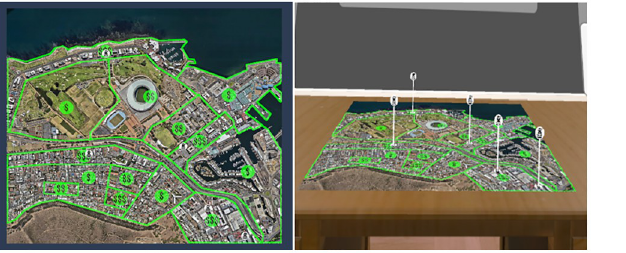
Fig 2. A map as displayed on a desktop monitor, with income level and robberies selected, compared to the same information displayed in virtual reality. (Google; Imagery: CNES/Airbus, Maxar Technologies; Map Data: AfriGIS (Pty)